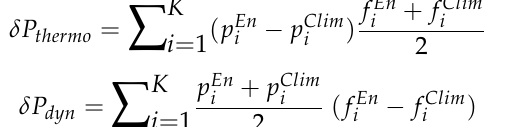
Figure 6. The progression of the WTs. The 95% confidence interval of the WT background frequency (the occurrence of WT transition due to chance) is shown with black shading. Frequencies signifi- cantly greater than the background frequency are shown with red bars; frequencies significantly less than the background bars are shown with blue bars.